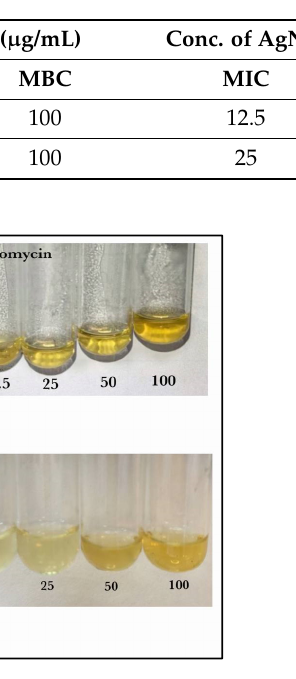
Table 5. MIC and MBC of the bacterial isolates.